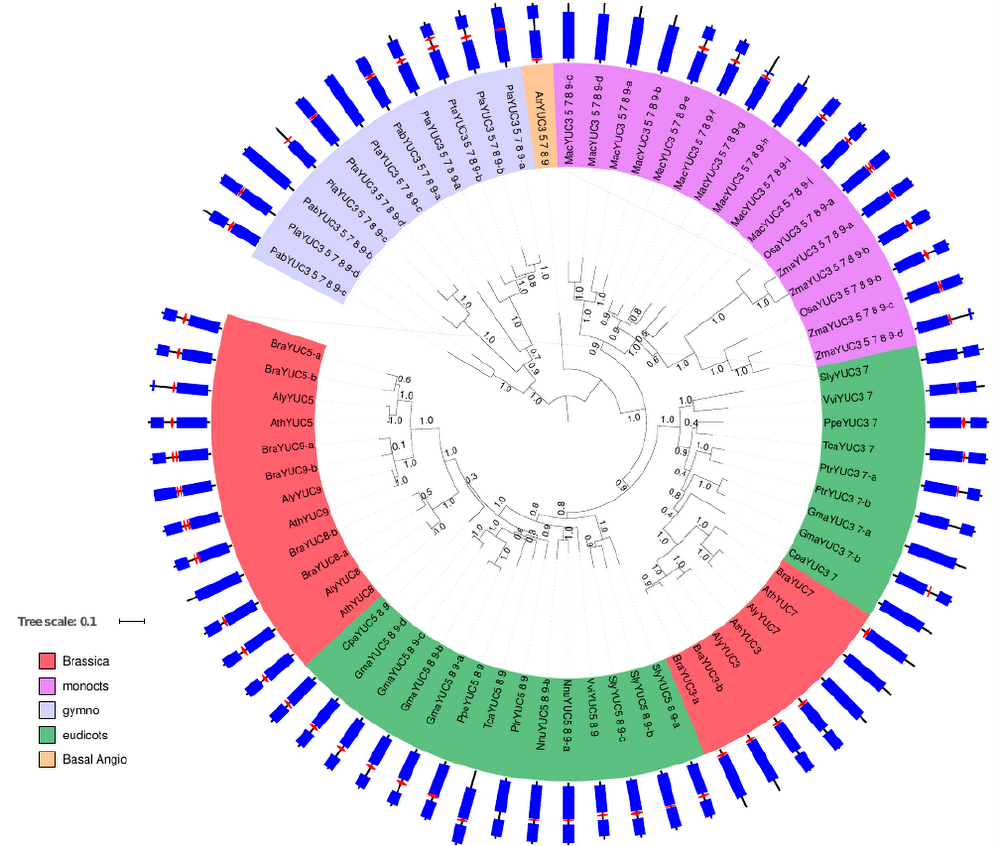
Figure 2. Phylogenetic tree of YUC3, YUC7, YUC8, YUC5 and YUC9 homologues proteins. A fast-tree using the maximum likelihood method [16] was applied on YUC3 YUC7 YUC8 YUC5 and YUC9 protein homologues constructed from an alignment using the MUSCLE (MUltiple Sequence Comparison by Log-Expectation) alignment tool with default parameters [18]. Bootstrap values are given on the branches. Gene labels are constructed with the three letters from the species name (Table 1) and the gene name of the A. thaliana homologues (Table S1). The color of the label shows the lineage of the plant. The corresponding protein domains (circle periphery) are obtained using InterProScan [15], red hexagons represent the TMD in the protein if applicable, and blue rectangles indicate the flavin-dependent monooxygenase domain typical for YUC proteins.